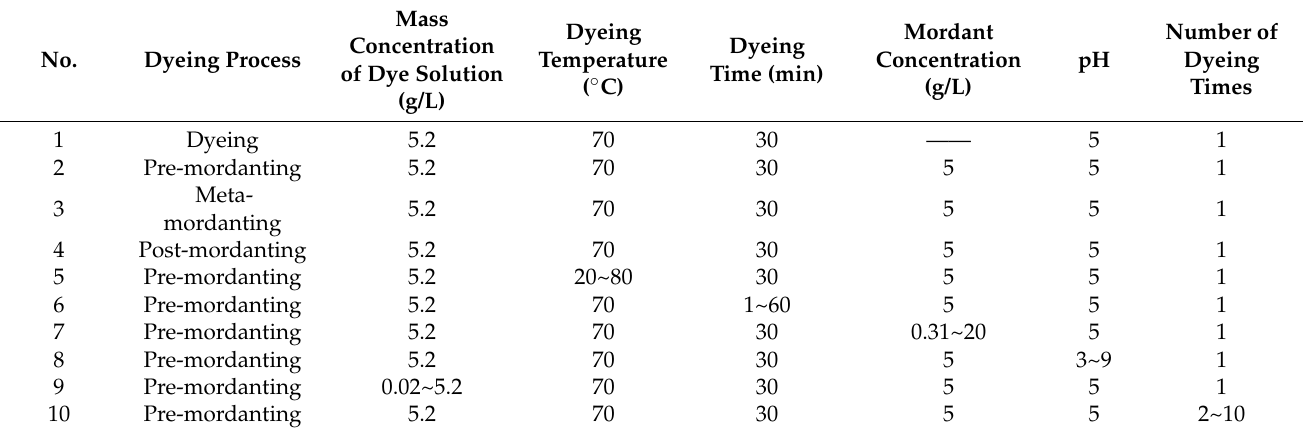
Table 2. Parameters in different dyeing